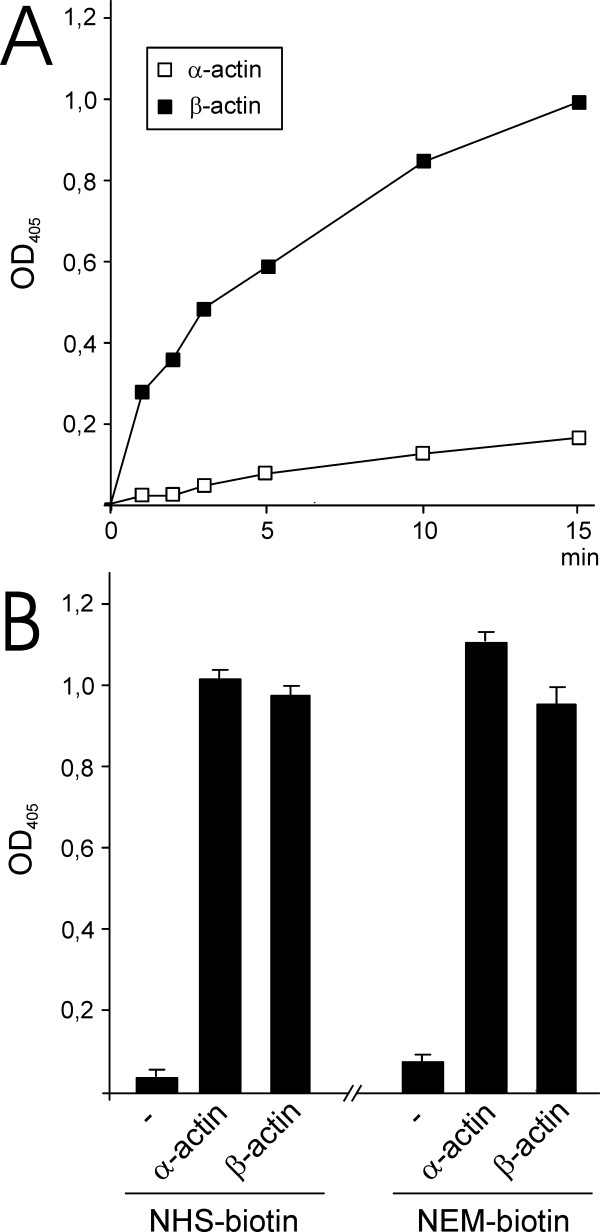
Kinetics of α- and β-actin glutathionylation. (A) Glutathionylation of α- and β-actin by GSH. The ELISA plates were coated with actin as described in Methods, incubated first with 5 mM DTT to reduce thiols and then incubated with 1 mM GSH at 22°C. (B) Quantification of relative amounts of actin immobilized on the plates (primary amine groups labelled with NHS-biotin) and accessible free thiols (thiols labelled with NEM-biotin).